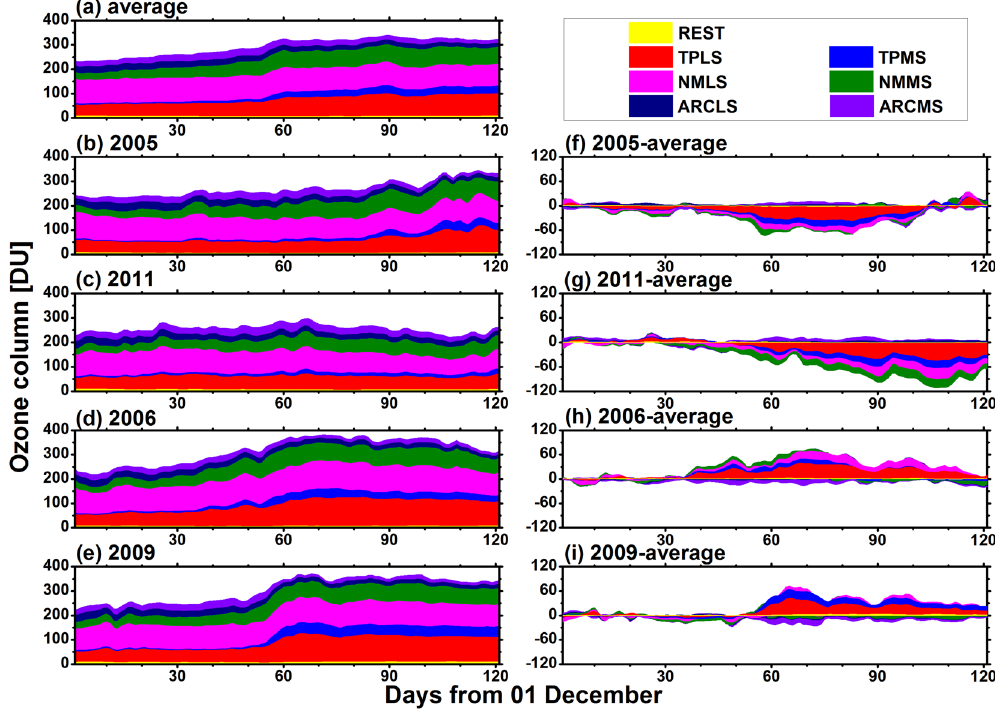
Figure 2. The mean contributions from seven ozone source regions to the lower stratospheric ozone column (unit: DU) over the Arctic region from December to March: ( a ) the 7-year average from 2005–2011, ( b ) 2005, ( c ) 2011, ( d ) 2006, and ( e ) 2009. All values are vertically integrated results from the tropopause to 20 hPa. ( f – i ) Show the differences between the ozone contributions in the four specific years (2005, 2011, 2006, and 2009) and the 7-year average, respectively. The abbreviations for the source regions have been explained in Table